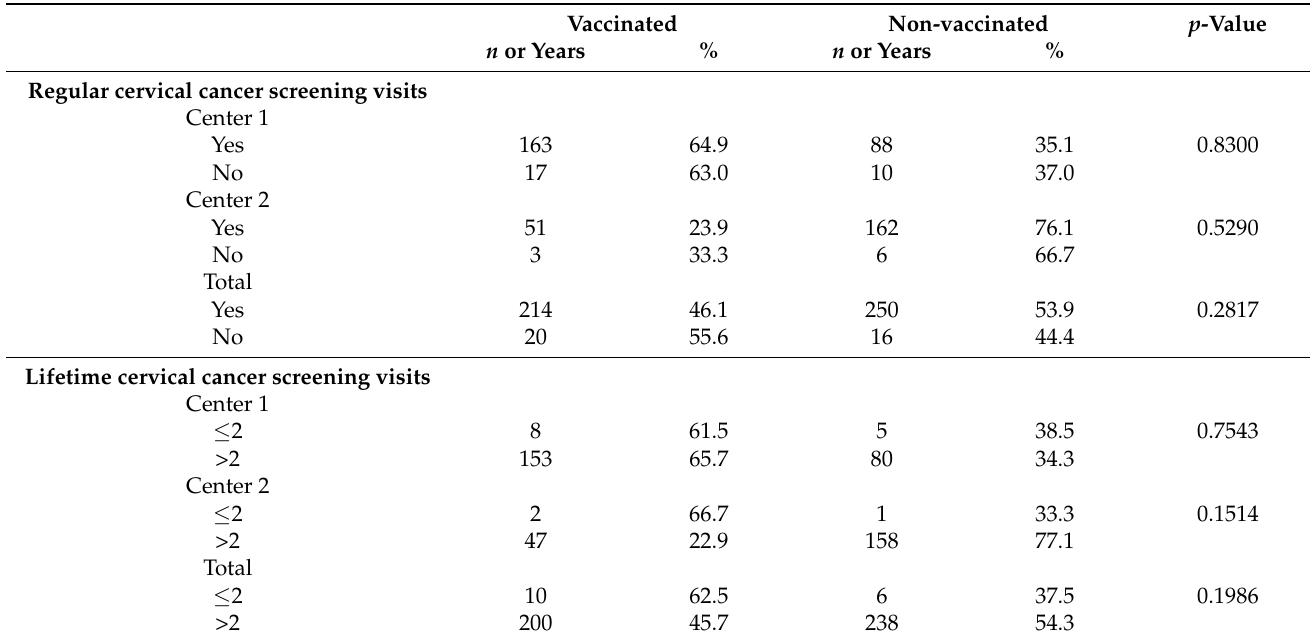
Table 1. Cont. Vaccinated Non-vaccinated p